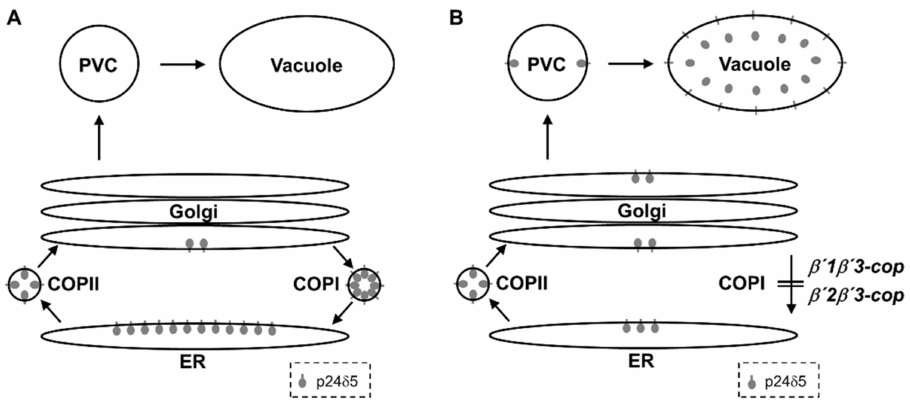
Figure 7. Trafficking of p24 δ 5 in wild-type and β ’-COP double mutant plants. ( A ) In wild-type plants, p24 δ 5 mainly localizes in the ER at steady-state due to efficient, COPI-dependent, Golgi-to-ER transport. ( B ) In β ’-COP double mutants, p24 δ 5 is not efficiently retrieved from the Golgi apparatus and thus follows a default pathway to the vacuole, where the luminal part of the protein (including RFP in the case of RFP–p24 δ 5) is cleaved and released to the vacuole